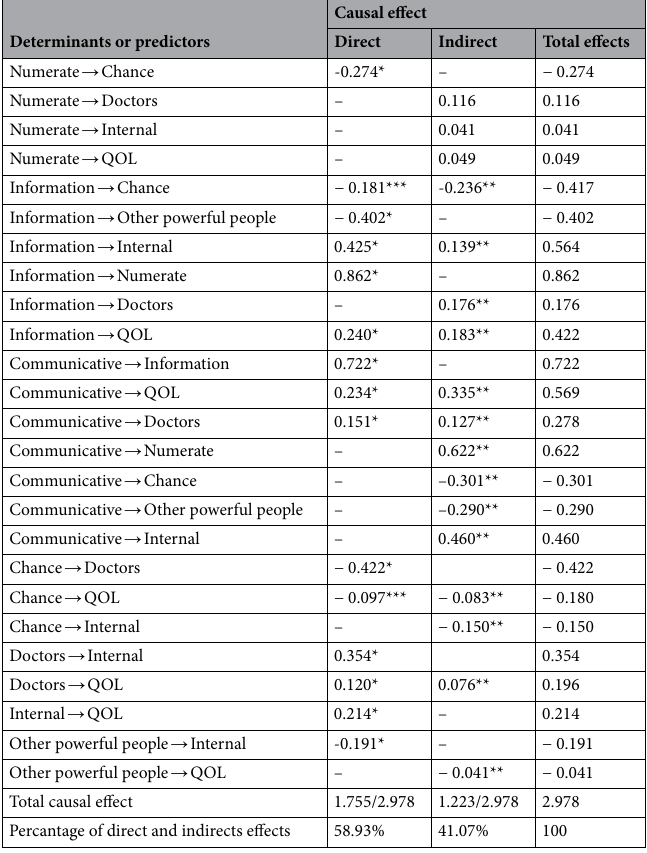
Table 7. Direct and indirect paths between subscales in PATH analysis. *P < 0.001, **P = 0.001, *P < 0.005.